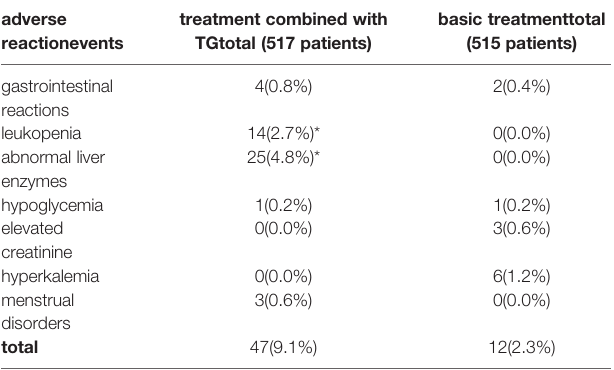
TABLE 3 | Statistics of adverse reaction events after 6-month